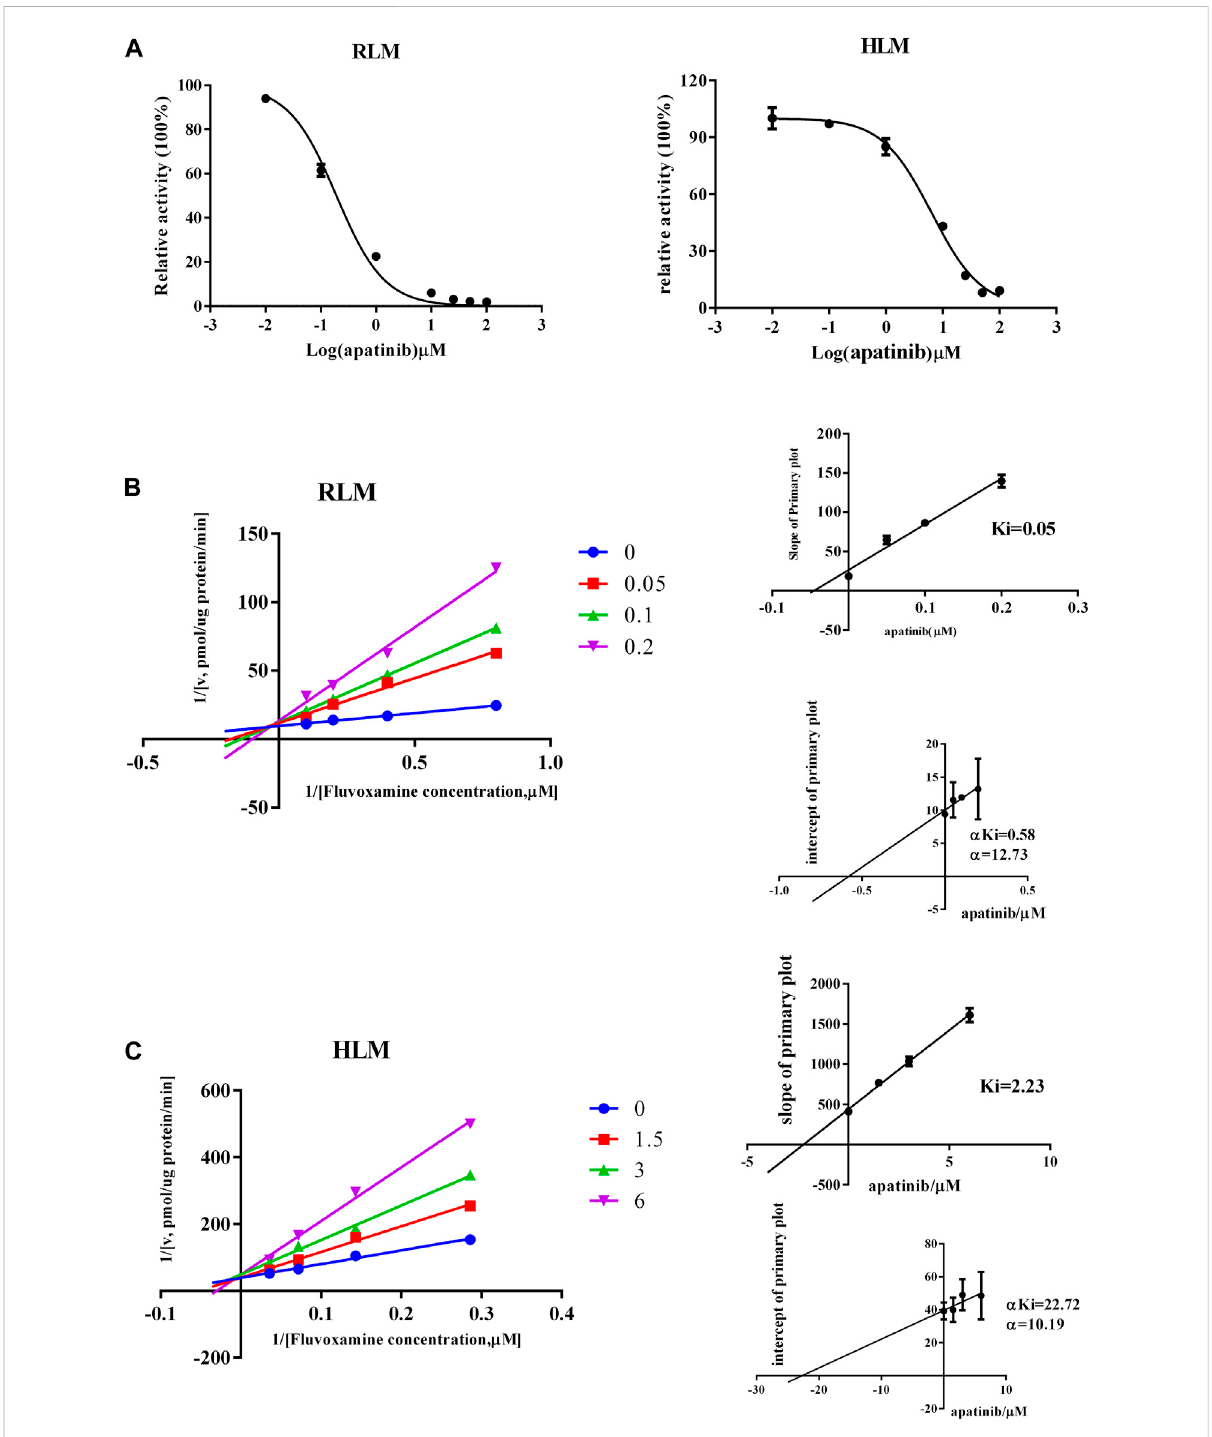
FIGURE 5 Apatinib inhibited the metabolism of fl uvoxamine with a mixed mechanism both in RLM and HLM. (A) The effect of apatinib on inhibiting fl uvoxamine metabolism. (B,C) Lineweaver-Burk plot and the secondary plot for Ki in the inhibition of fl uvoxamine catalyzing, n = 3.